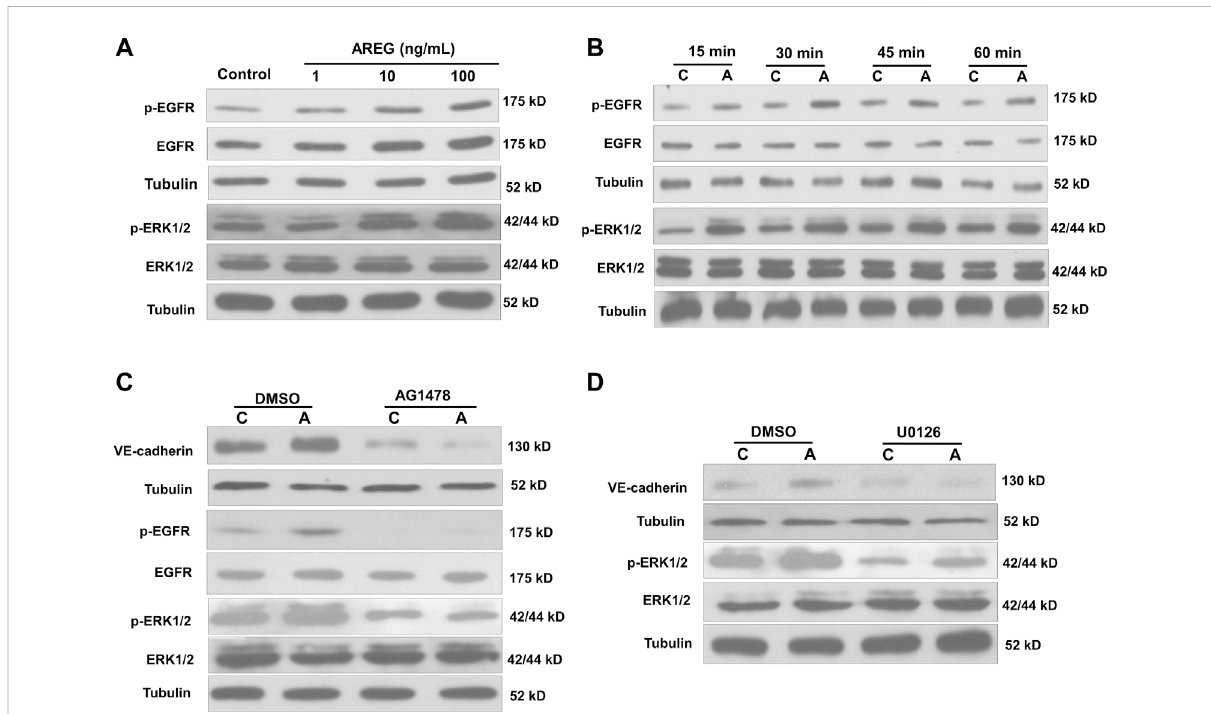
FIGURE 4 Effects of the inhibitors AG1478 and U0126 on the AREG-induced increase in phosphorylated EGFR and ERK1/2 in SVOG cells. (A) Cells were treated for 15 min with varying concentrations (0, 1, 10 or 100 ng/ml) of AREG, and the phosphorylation levels of EGFR and ERK1/2 were examined using western blotting. (B) Cells were treated with AREG (100 ng/ml) for 15, 30, 45 or 60 min, and the phosphorylation levels of EGFR and ERK1/ 2 were examined by western blotting. (C,D) SVOG cells were pretreated for 1 h with a vehicle control (DMSO), AG1478 (10 µM) (C) or U0126 (10 µM) (D) and then treated for an additional 15 min (for detecting phosphorylated EGFR) or 24 h (for detecting VE-cadherin) with or without AREG (100 ng/ml). The phosphorylation levels of EGFR, and VE-cadherin were examined by western blotting. Values labeled with different letters are signi fi cantly different ( p < 0.05), n = 4. C, control; A,